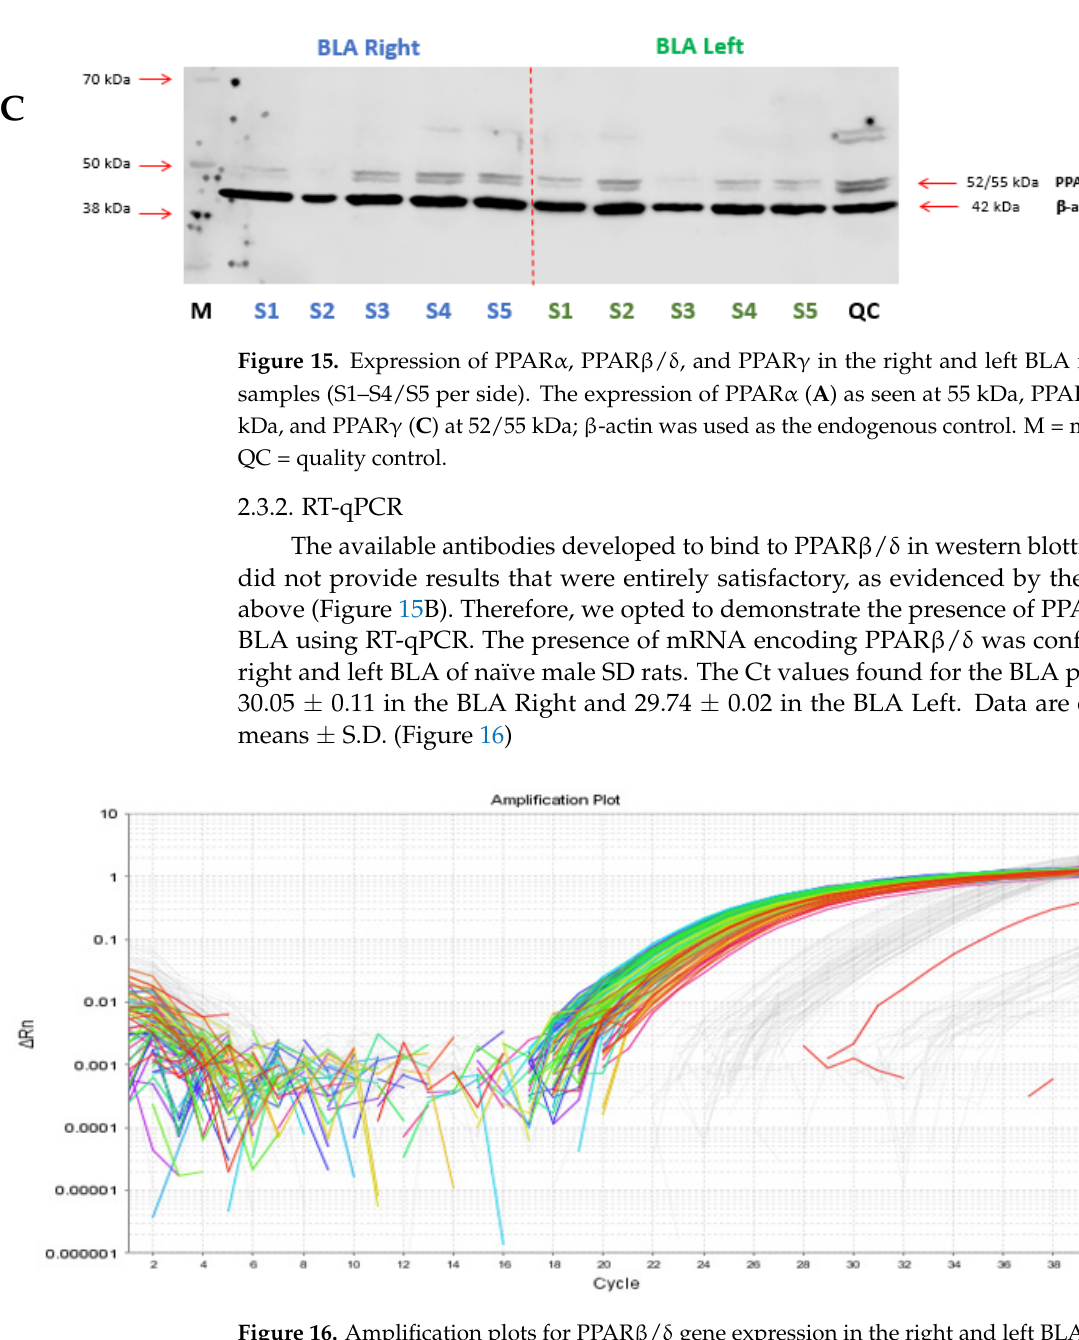
19 of 37 Figure 14 . Effects of fear-conditioning and intra-BLA administration of selective PPAR α , PPAR β / δ , and PPAR γ antagonists on the levels of, PEA ( A ), AEA ( B ), and OEA ( C ). Post hoc analysis with Dunn’s test indicated that FC GW6471-treated rats had decreased levels of PEA compared to the FC Vehicle treated rats in the right BLA ( $ p < 0.05). Data are expressed as median with interquartile range and min/max ( n = 6–9 rats per group). 2.3. Expression of PPARs in the BLA 2.3.1. Western Blotting PPAR α , PPAR β / δ , and PPAR γ expression was confirmed in the right and left BLA of naïve male SD rats (Figure 15). The bands for PPAR α (55 kDa) and PPAR β / δ (52 kDa) were obtained with the use of a monoclonal antibody. The double bands for PPAR γ are a consequence of the expression of two subtypes of PPAR γ : PPAR γ 1 and PPAR γ 2 . The 42 kDa band corresponded to β -actin, used as an endogenous control.